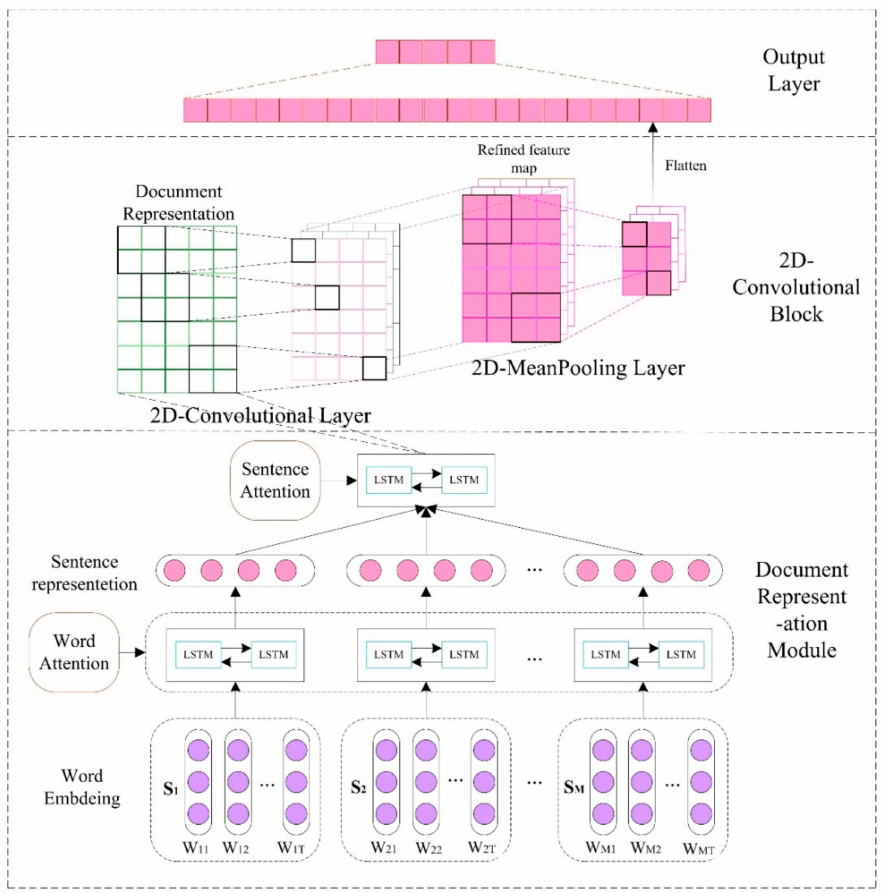
Figure 1. Structure of the